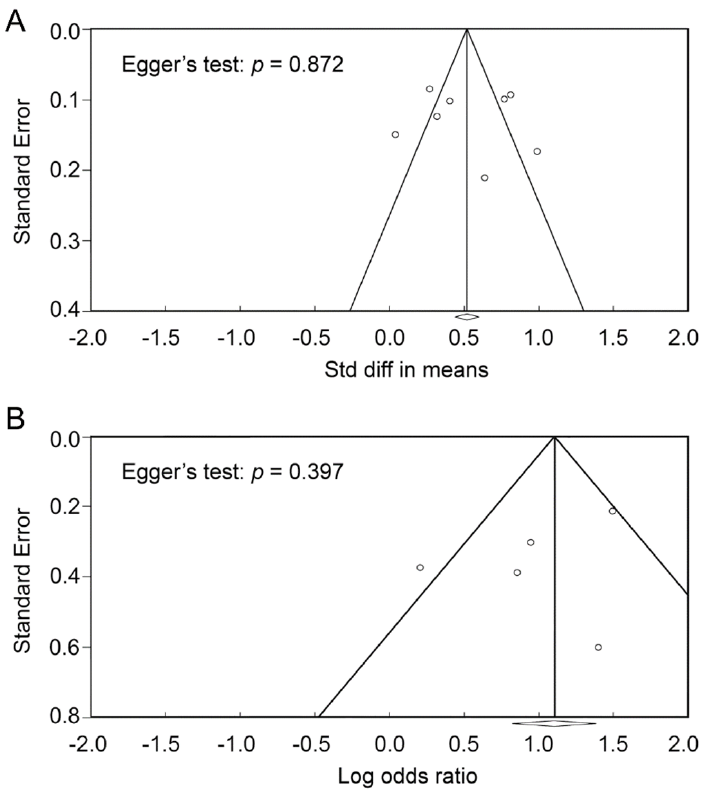
Figure 5. Funnel plot with Egger’s test showing no publication bias in ( A ) the mean difference in fibrinogen-to-albumin ratio (F/A ratio) in both groups [24,25,32–35,37,38], and ( B ) risk of poor prognosis in patients with high F/A ratio [12,34–36,38].